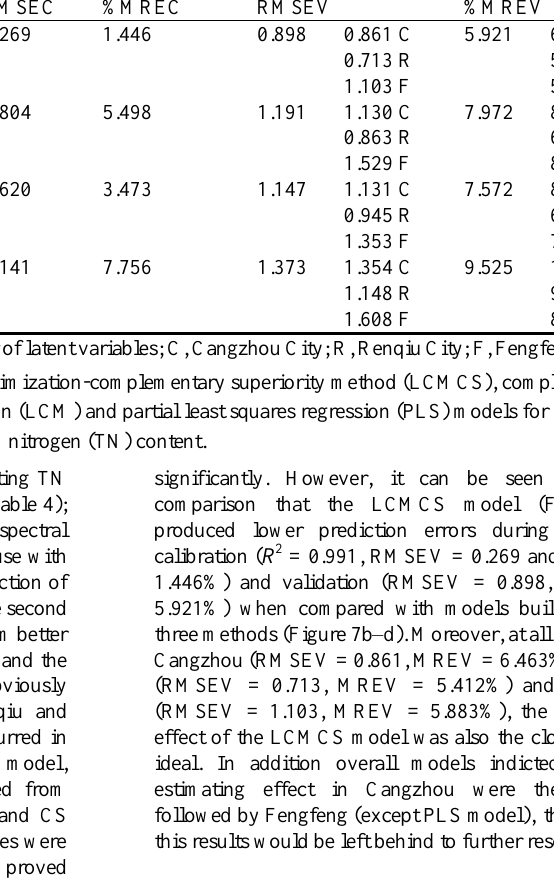
Table 3. Comparisons of the performance of models established by the local correlation maximization-complementary superiority method at different correlative levels of the first derivative differential (FDR (optimal spectrum [OSP]) and the